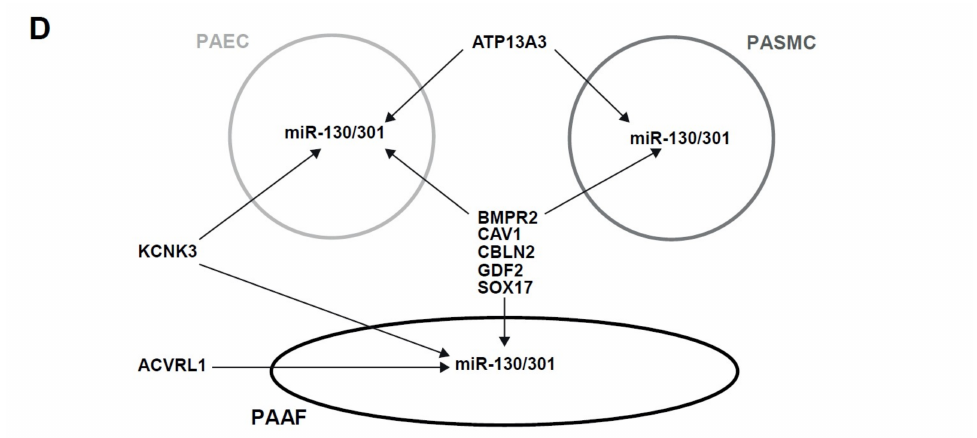
Figure 2. Factors genetically associated with PAH modulate the expression of miR-130/301 family members. ( A – C ) Following transfection with the indicated siRNA, transcript levels of miR-130/301 members were analyzed by RT-qPCR in PAAFs ( A ), PAECs ( B ), and PASMCs ( C ). Mean expression of a given miRNA in the control group (si-NC) was assigned a fold change of 1, to which corresponding miRNA levels in experimental groups were compared. Data are expressed as mean ± SD (* p < 0.05, ** p < 0.01) of three independent experiments. One-way ANOVA and post-hoc Tukey tests were used for group comparisons. ( D ) Schematic of the main